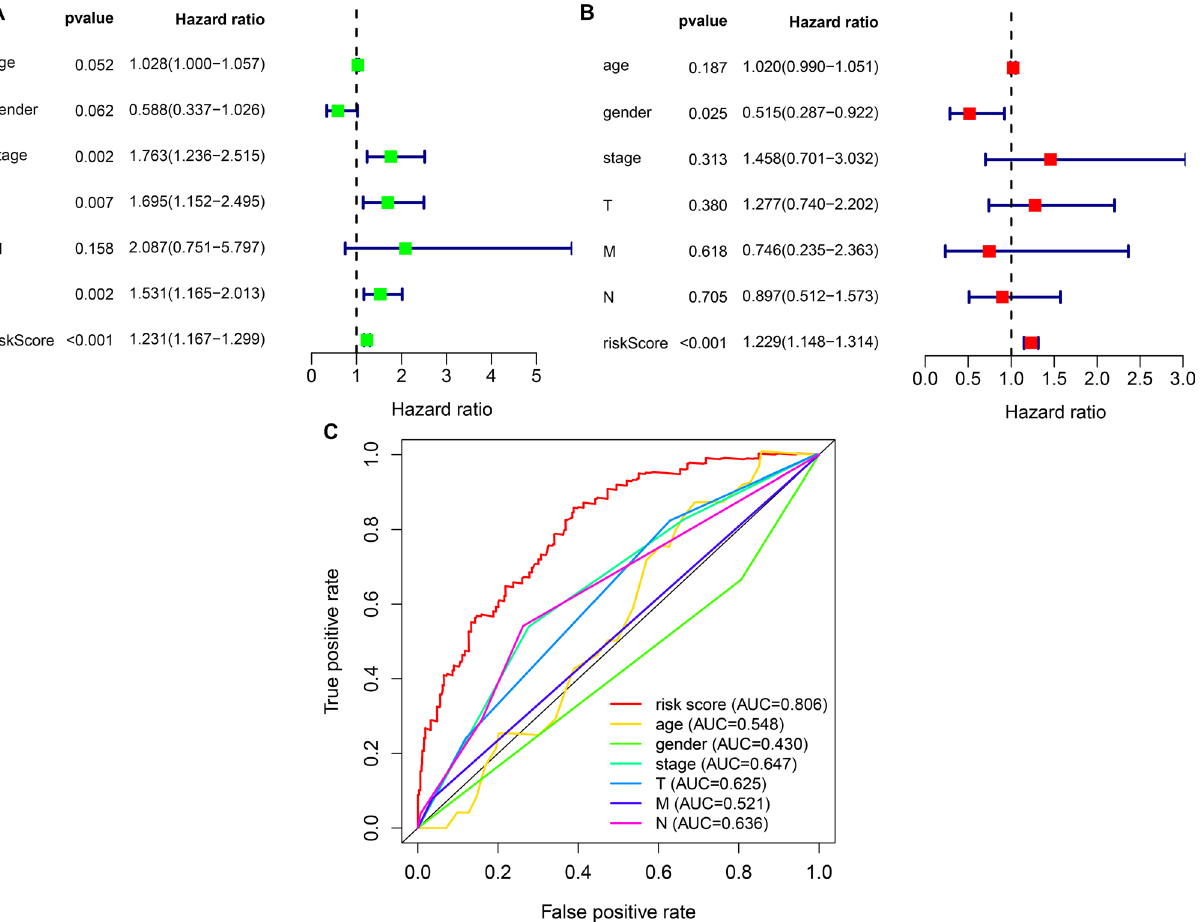
Figure 5. Assessing the predictive independency of this prognostic immune-related lncRNA signature for bladder cancer prognoses. ( A ) Univariate cox regression analyses of the correlations of age, gender, stage, T, N, M and risk score with bladder cancer prognoses. ( B ) Multivariate cox regression for evaluating the independent predictive factors. ( C ) Comparing the AUC values of age, gender, stage, T, N, M and risk